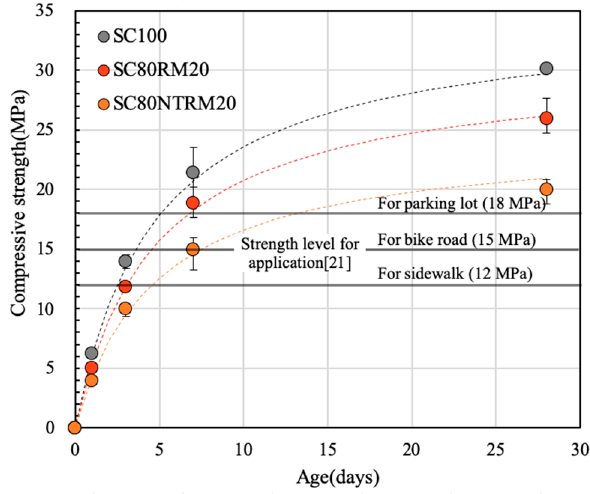
Figure 6. Compressive strength of different RM-type mortar specimens.